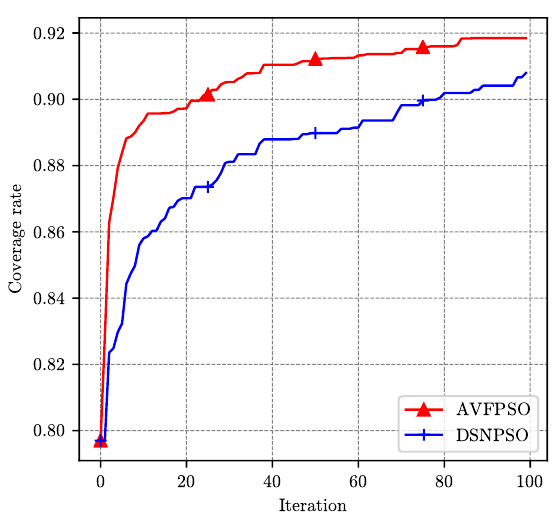
Figure 9. The coverage rate with 10 particles.